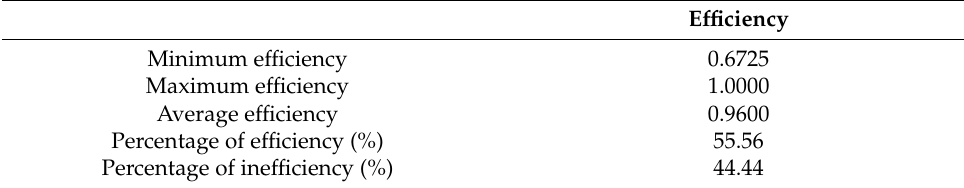
Table 3. Summary of